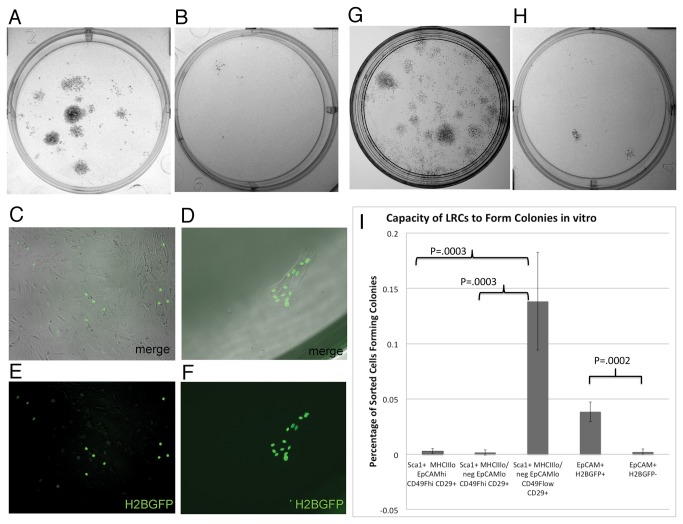

In vitro growth potential of H2BGFP LRCs.Methylene blue stained colonies derived from FACS sorted CD45- EpCAMlo MHCIIlo/-Sca1+H2BGFP+ LRCs (A) or CD45-MHCIIintEpCAMhi Sca1+ H2BGFP+ stroma (B). C. Merge of H2BGFP expression and phase contrast image of expanded EpCAMloMHCIIlo/- H2BGFP+ LRCs 1 week after sorting, demonstrating dramatic in
vitro growth. D. Merge of H2BGFP expression and phase contrast image showing limited expansion of EpCAMhi MHCIIintH2BGFP+ LRCs 1 week after sorting. E. H2BGFP expression in same field as C. F. H2BGFP expression in same field as D. These results are representative of 3 independent experiments performed with 10-12 week Dox fed H2BGFP mice. Methylene blue stained colonies derived from FACS sorted CD45-MHCIIlo/-EpCAMlo Sca1+CD49Flo CD29+ (G) or CD45-MHCIIintEpCAMhiSca1+CD49FhiCD29+ stroma (H) derived from WT C57BL/6J mice. I. Colony forming potential of sorted LRCs and defined TEC subsets sorted from dissociated thymus derived from postnatal C57BL/6J mice. Error bars show standard deviation of means calculated from 5 independent experiments. P values are derived by comparison of colony forming potential of sets of populations using T test.